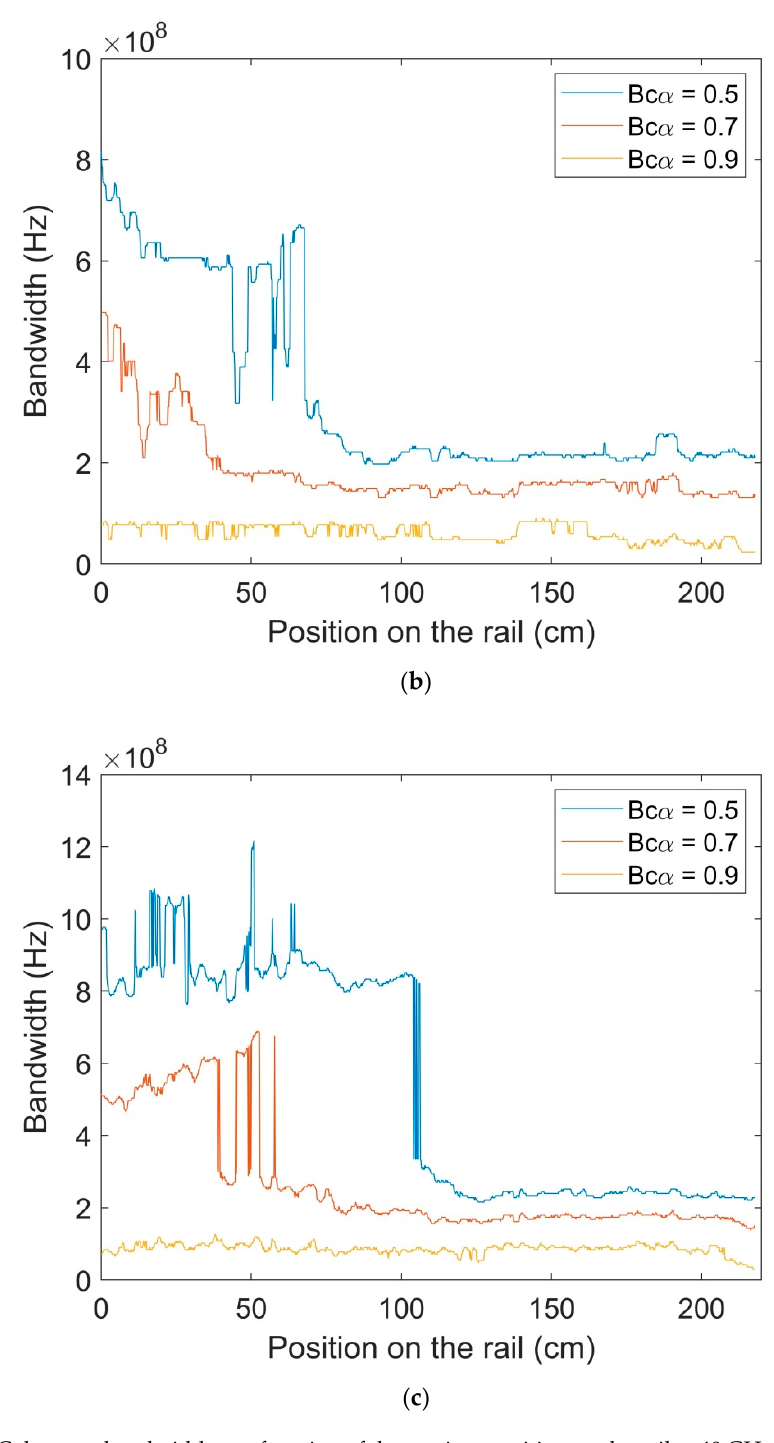
Figure 12. Coherence bandwidth as a function of the receiver position on the rail at 40 GHz received by ( a ) antenna 2; ( b ) by antenna 3; ( c ) by antenna 4.